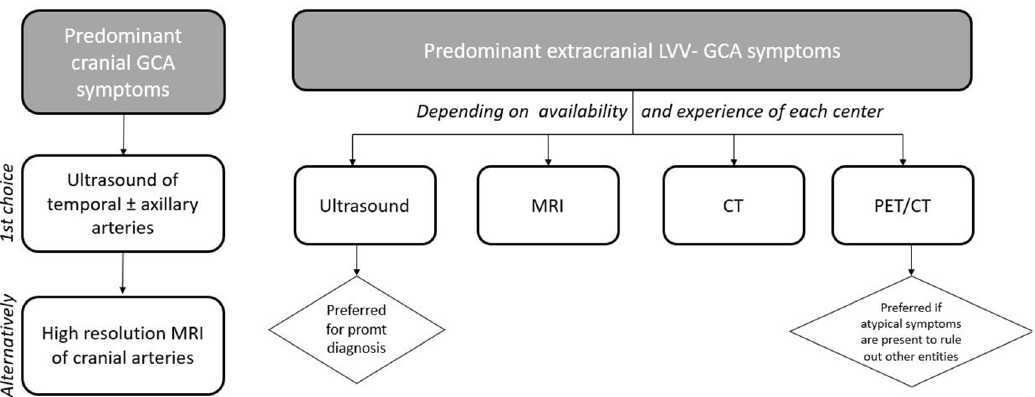
Figure 3. Algorithm for the use of imaging techniques in giant cell arteritis in clinical practice.